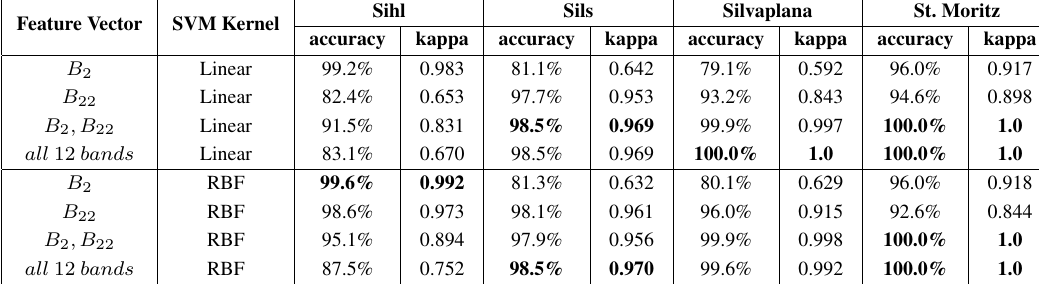
Table 8: Results from winter 2011 - 12 for MODIS data. Comparison of 4 -fold cross-validated SVM results. The ground truth data displayed on Table 3 is used.